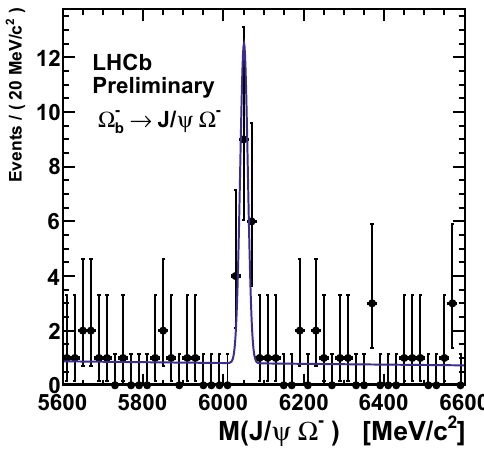
Figure 12. Ω − b candidates invariant mass distribution.